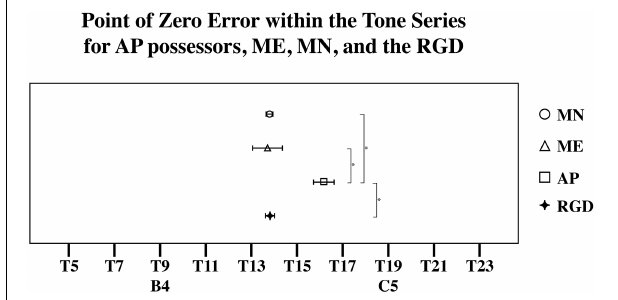
FIGURE 12 | The location of each group’s point of zero error or central tendency point. Significant pairwise comparisons (alpha 0.05) using a Tukey HSD test are marked by an asterisk [ ∗ ]. Note that AP possessors’ central tendency point is shifted away from the true center of the distribution, and toward’